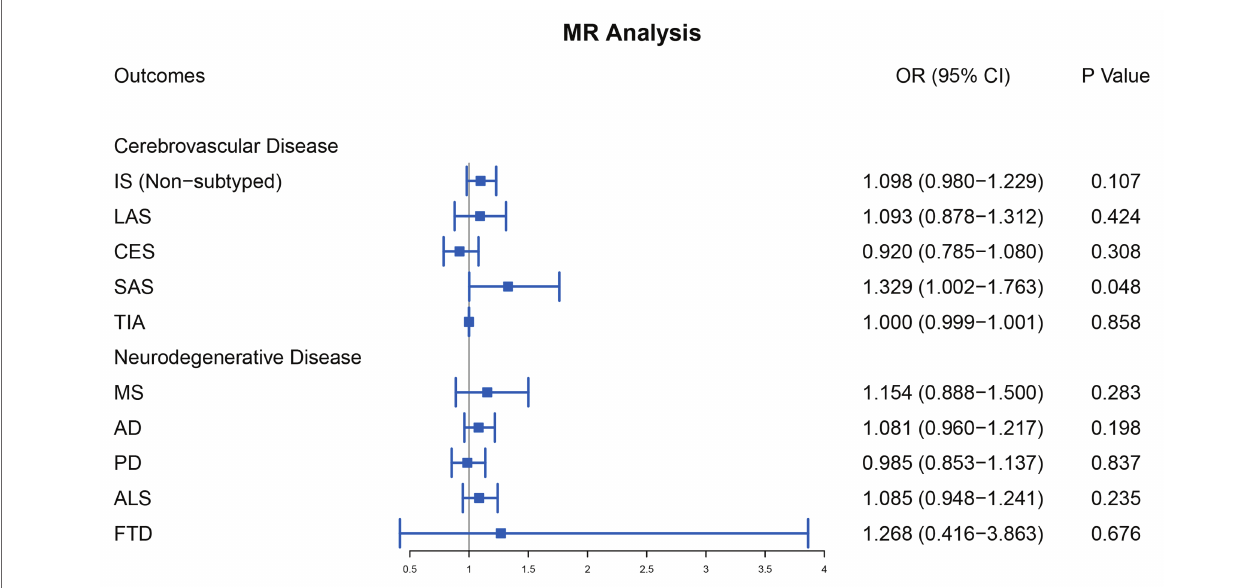
FIGURE 2 | Mendelian randomization analysis of the association between plasma Hcy level and cerebrovascular and neurodegenerative diseases. OR, odds ratio; CI, confidential interval; IS, ischemic stroke; LAS, large artery atherosclerosis stroke; CES, cardioembolism stroke; SAS, small artery occlusion stroke; TIA, transient ischemic attack; MS, multiple sclerosis; AD, Alzheimer’s disease; PD, Parkinson’s disease; ALS, amyotrophic lateral sclerosis; FTD, frontotemporal